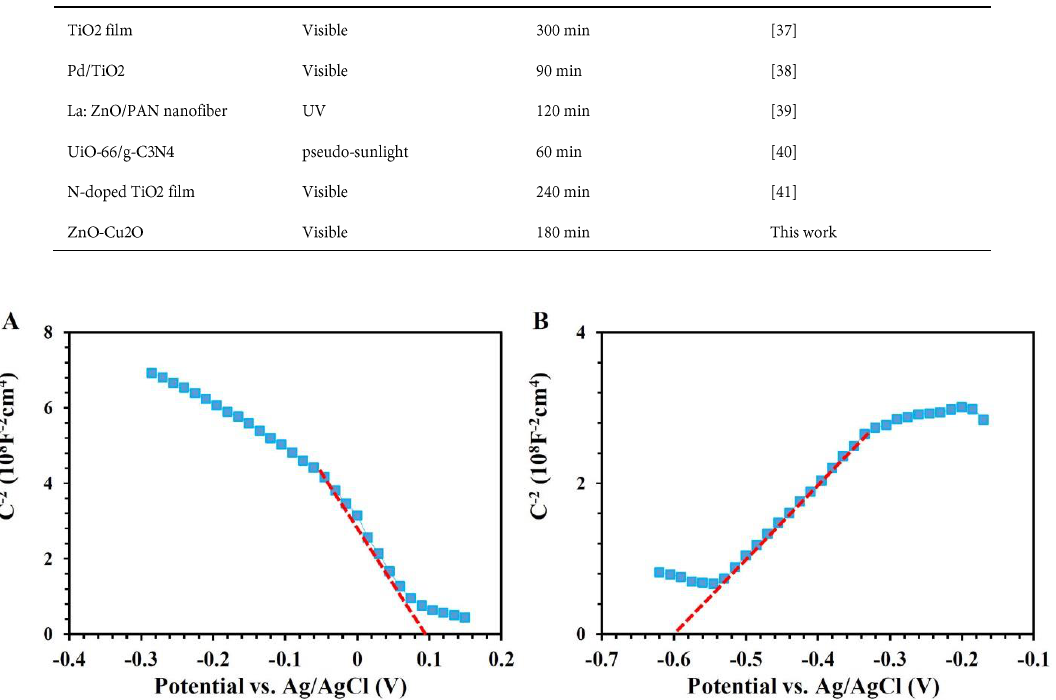
Fig. 5. Mott-Schottky measurements for (A) Cu